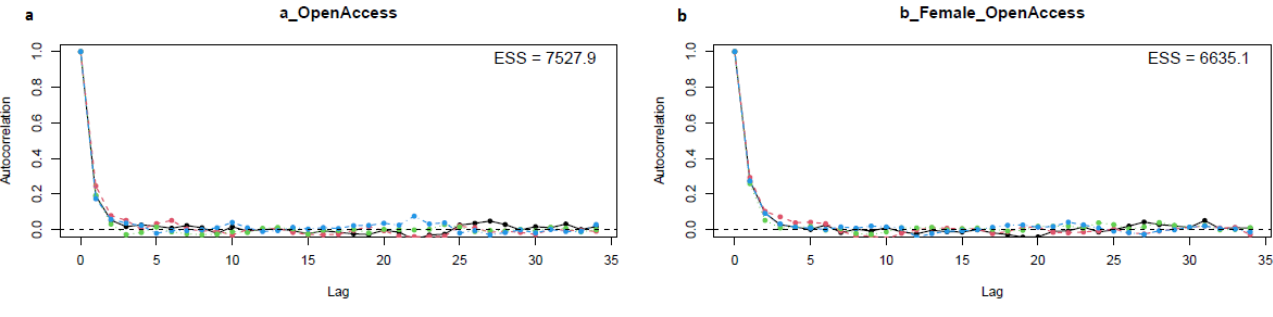
Figure A2. Autocorrelation plots of parameters: ( a ) Constant ; ( b ) Female ; ( c ) Female × FirstFemale ; ( d ) Female × SoloFemale ; ( e ) Female × AllFemale. Table A1. Probabilities of Gold Access publishing by gender-based authorship structures. SoloFemale ‘Written by a solo female